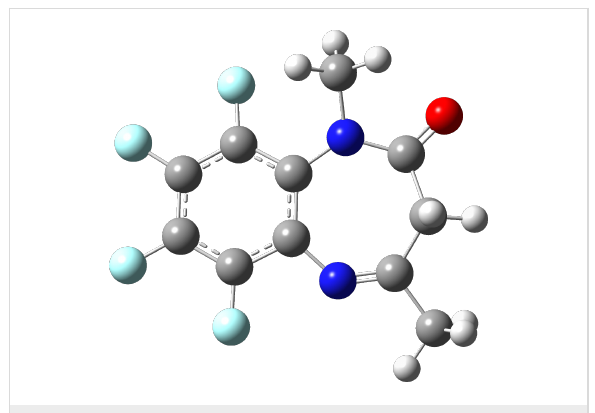
Figure 10: The optimized geometry of the TS of 2a